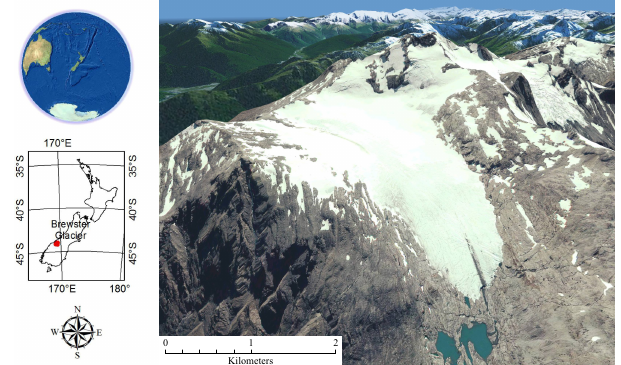
Figure 1. Situation of Brewster Glacier. Quickbird image from 8 February 2011 (KiwImage, includes copyrighted material of Dig- italGlobe, Inc, All rights Reserved) draped onto a 15m-resolution DEM (Columbus et al., 2011).